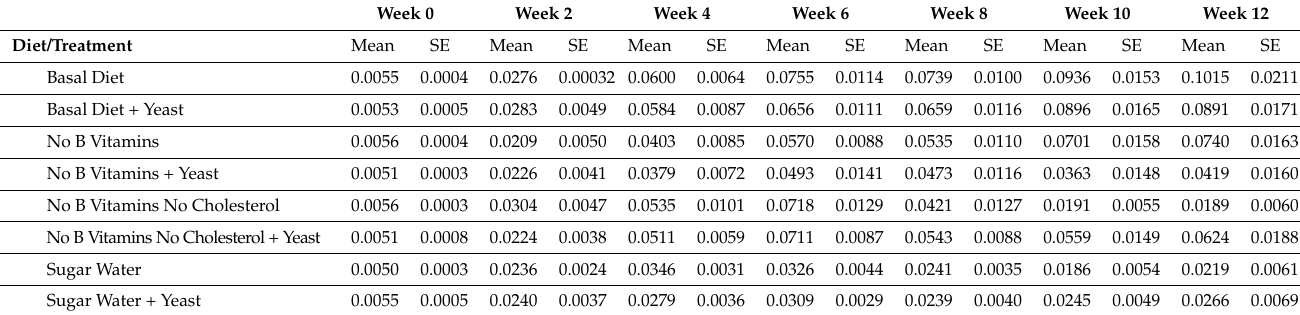
Figure 1. Average ( n = 8) brood weights (mg) over 12 weeks for small worker colonies of C. vicinus (non-defaunated) fed various chemically defined diets with some nutrients deleted and the same diets augmented with a yeast associate. Table 2. Average ( n = 8) brood weights (mg) and standard errors at 2 week intervals over 12 weeks for small worker colonies of C. vicinus (non-defaunated) fed various diets chemically defined diets with some nutrients deleted and the same diets augmented with a yeast associate (this table is included because standard error bars are not discernable in Figure 1).